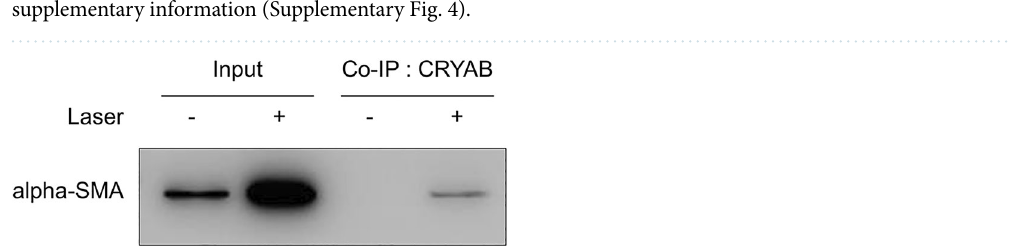
approximately 45% of patients developed fibrotic scarring 2 years after anti-VEGF treatment 8 . Thus, fibrotic scarring is a primary biomarker to predict loss of vision in patients with nAMD. In this study, we examined the effects of AIF on VEGF expression and fibrosis in AMD models. We dem- onstrated that AIF significantly reduced released VEGFA in H 2 O 2 treated ARPE-19 cells. Thus, these findings suggest that AIF may inhibit chorioretinal neovascularisation by reducing VEGF induced by oxidative stress. Parallel to previous studies, we found that AIF has an inhibitory effect on oxidative stress and angiogenesis 17,34 . Furthermore, TCM induced the increase in VEGF expression in ARPE-19 cells. However, AIF co-treatment with TCM reduced VEGF expression. According to the previous reports, activated macrophages are related to AMD pathological process 24,25 . In addition, it has been reported that VEGF mediates angiogenesis and inflammation 35 . Activated immune cells, such as macrophages, are the key source of cytokines in the inflamma- tory responses, which were ameliorated by AIF 34 . We demonstrated that AIF may inhibit VEGF production and